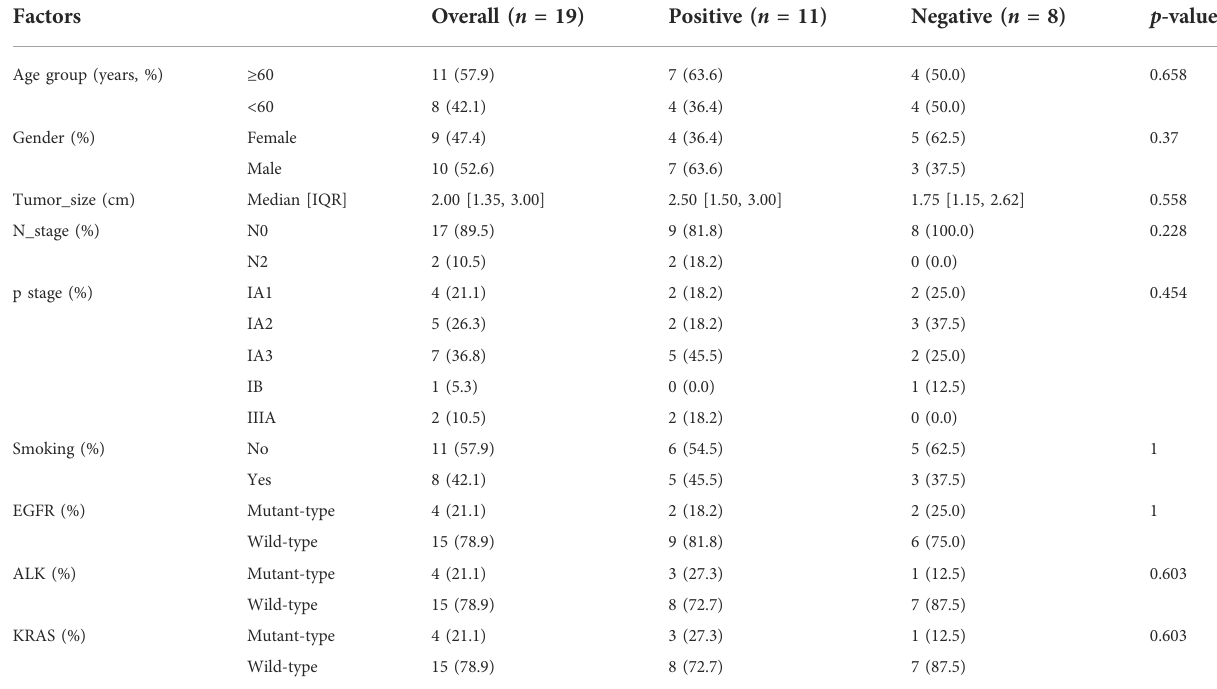
TABLE 1 Clinical factors of STAS_positive and STAS_negative